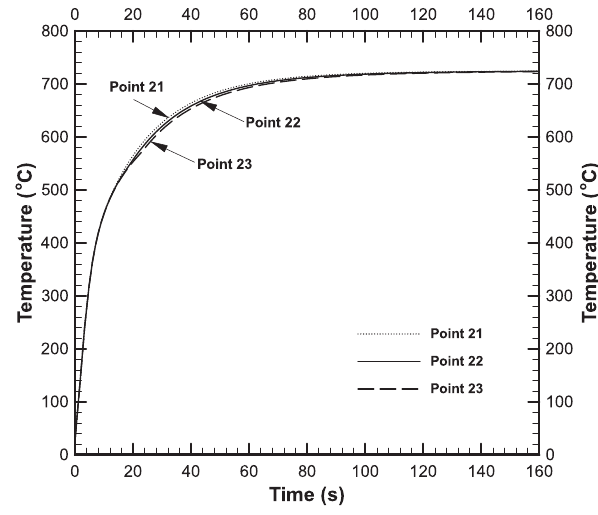
Fig. 9: Comparison for calculated temperature histories of compact points 21, 22 and 23 shown in Figure